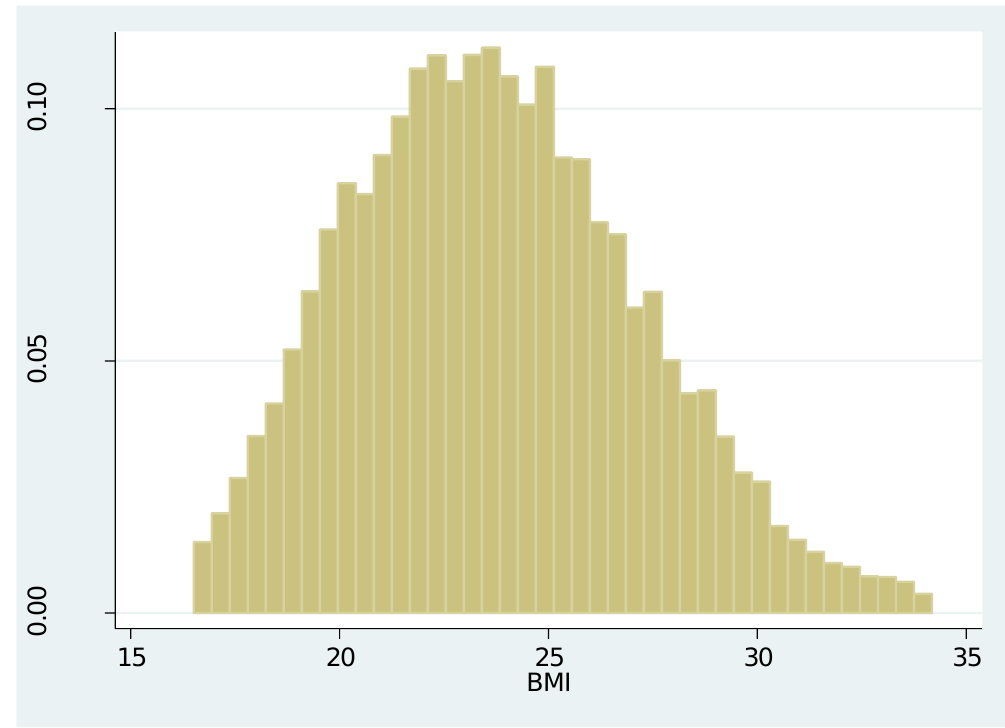
Figure 3. Histogram of the Body Mass Index (BMI) score.